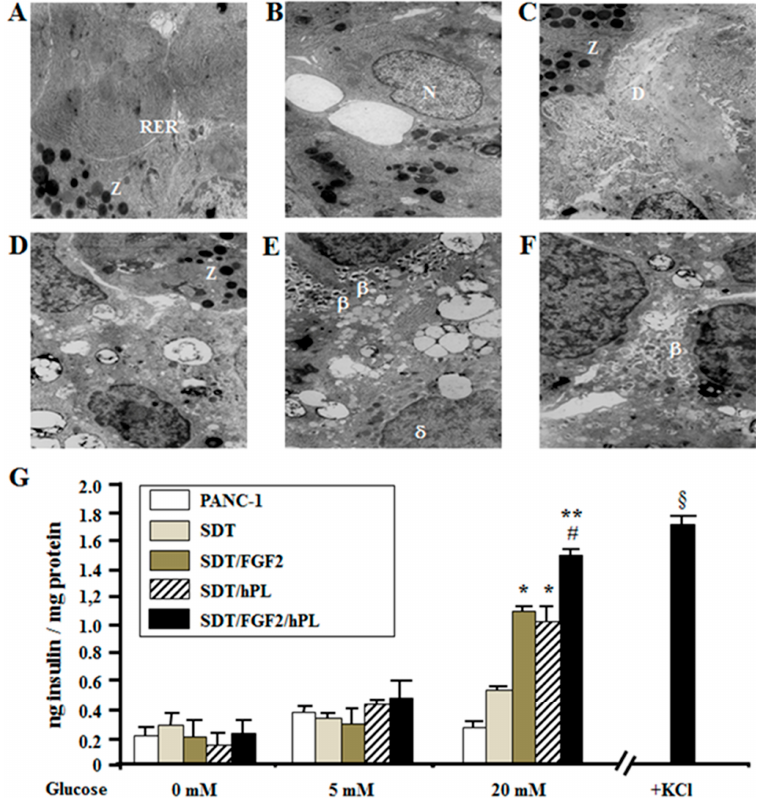
Figure 7. Ultrastructure of islet-like aggregates and insulin secretion assay. PANC-1 cells (70% of